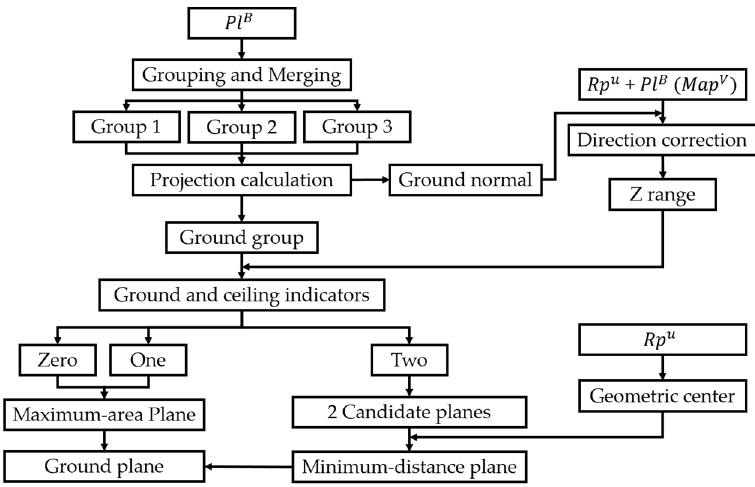
Figure 13. Pipeline of ground extraction.